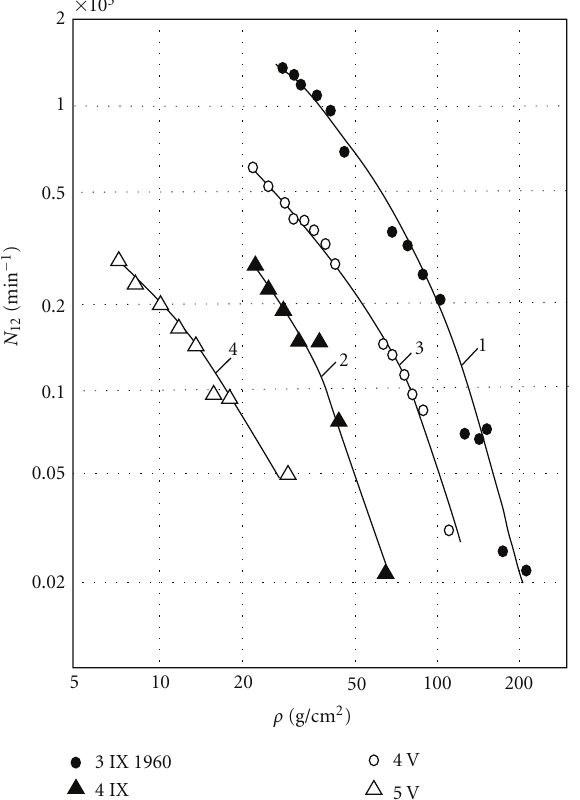
Figure10:Thecountingrates(permin)ofcoincidencepulsesversus altitude (in atmosphere pressure) of two GM tubes on radiosondes during four different SEP events [43].